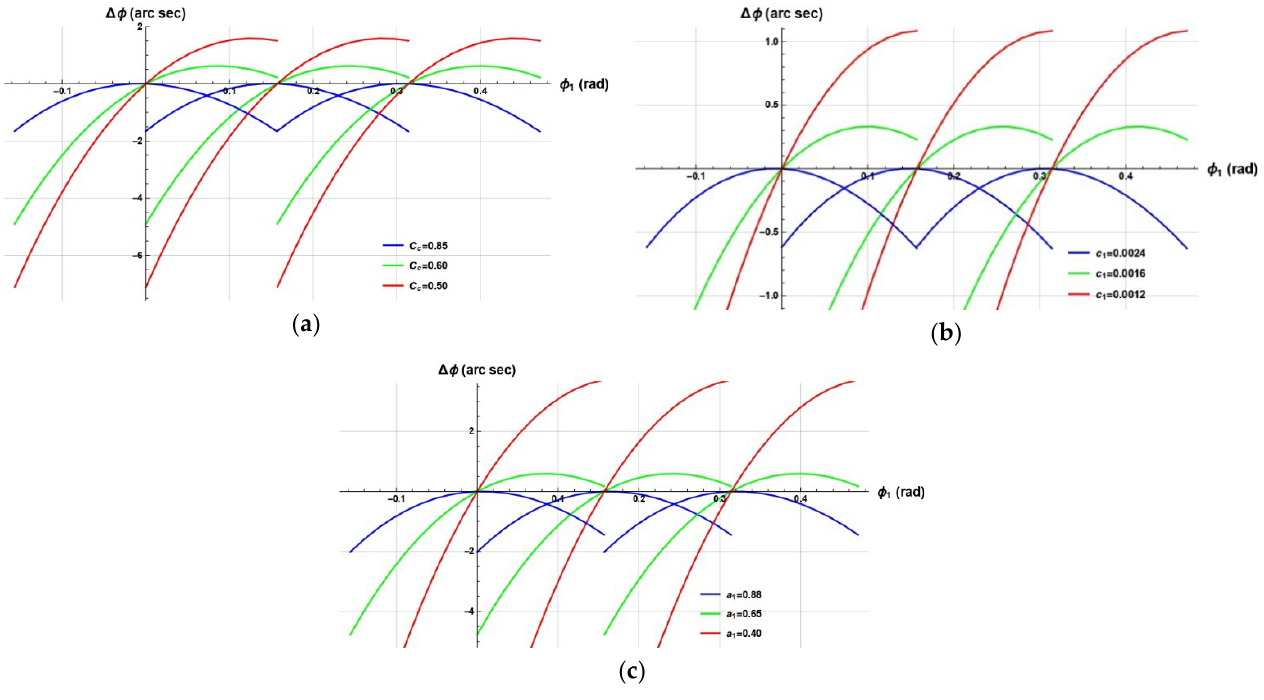
Figure 17. TE functions with different amounts of crowning: ( a ) circular, ( b ) parabolic, and ( c ) logarithmic.